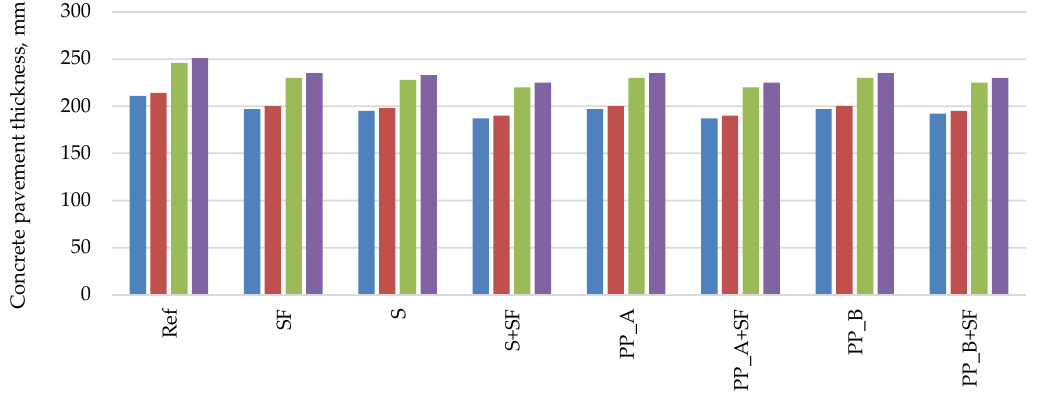
Figure 2. The minimum PCP thickness calculated with the design software StreetPave.